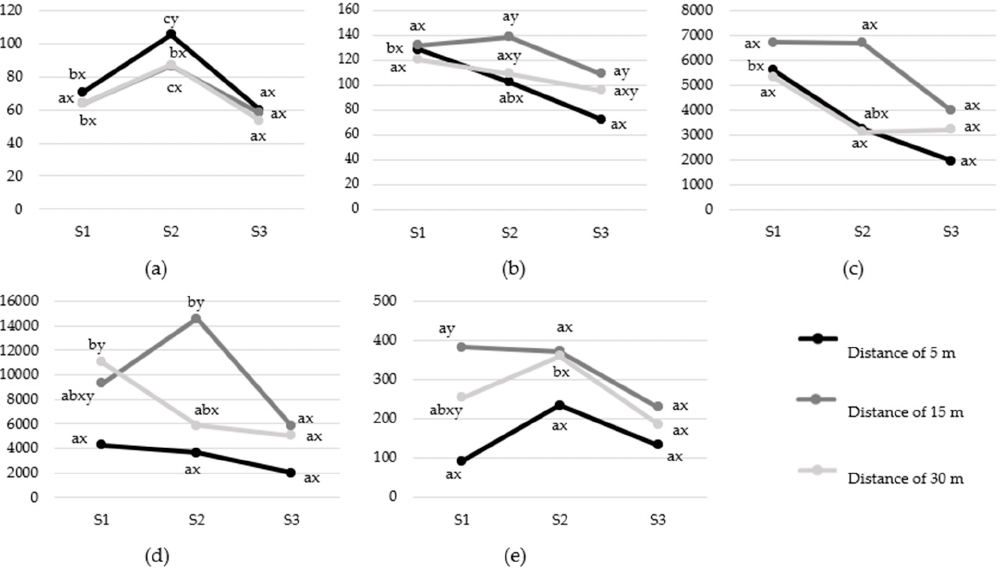
Figure 4. Mean values of: ( a ) HR [bpm]; ( b ) RMSSD [ms]; ( c ) HF [ms 2 ]; ( d ) LF [ms 2 ]; ( e ) LF/HF [%] in subsequent test periods: pre-sound (S1), sound (S2) and post-sound (S3) period depending on the sound exposure distance (30/15/5 m). Means marked with different letters differ significantly at p < 0.05 within the same distance in subsequent test periods S1, S2 and S3 (letters a, b) or between different distances within the same period (letters x, y).